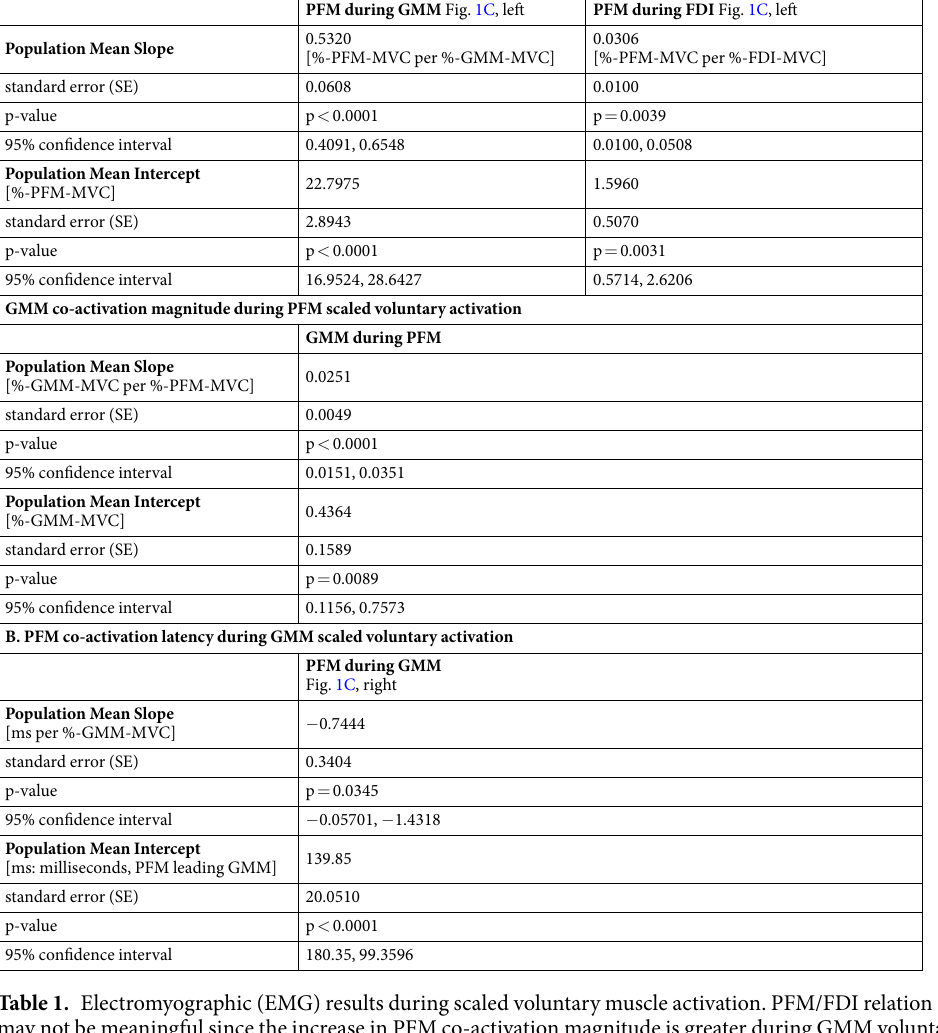
showed scaling in BOLD signal strength in accordance to the activation level of GMM in the three identified motor ROIs. Specifically, on the population level, BOLD signal strength significantly increased in SMA, M1-L, and M1-R during increased voluntary GMM activation (Table 2A). Based on previous studies 9–12,27,28 , we hypothesized that scaling BOLD signal strength in SMA would be to activate and scale PFM activity and that scaling BOLD signal strength in M1-L and M1-R would be to activate and scale GMM activity. However, the following fMRI results during scaling of the isolated-pelvic coordination pattern did not validate this initial hypothesis of localized control and representation of the PFM in SMA. Our ANCOVA analysis of BOLD signal strength showed scaling in BOLD signal strength in accordance to the activa- tion level of PFM not only in SMA ROI but also bilaterally in the primary motor cortex in M1-L and M1-R ROIs. Specifically, on the population level, BOLD signal strength significantly increased in SMA, M1-L, and M1-R dur- ing increased voluntary PFM activation (Table 2B). In contrast to previous studies, we can conclude that cortical control of human PFM may extend to motor regions lateral to the medial wall of the motor cortex.